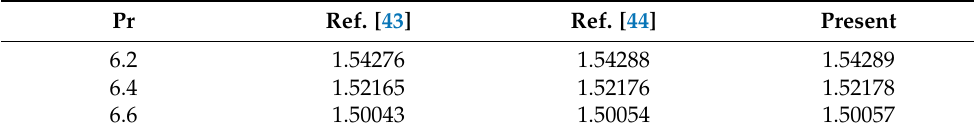
Figure 8. Versus φ Cu , φ Al Figure 8. Versus Table 6. Comparison with [43,44] taking Nu x Re x − 0.5